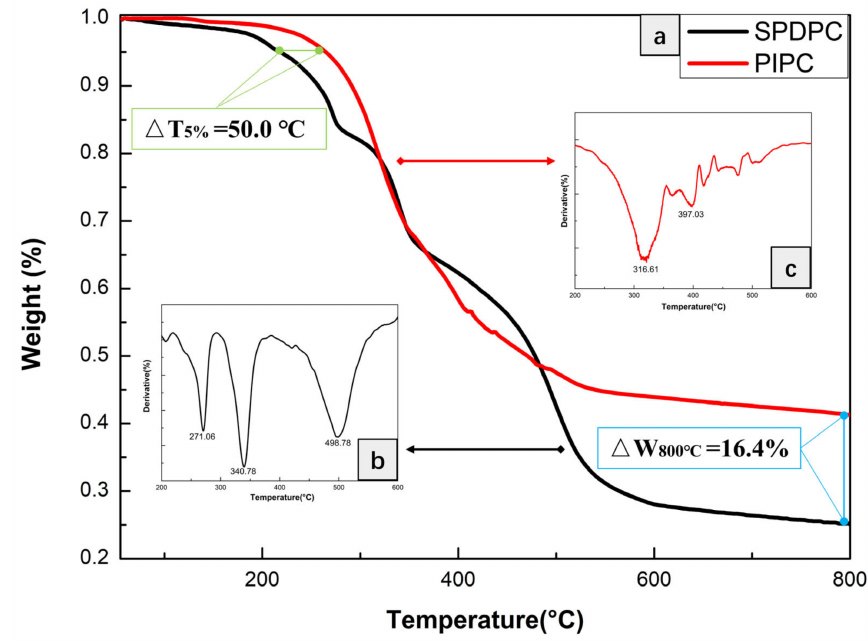
Figure 3. Thermogravimetry (TGA) curves of SPDPC and PIPC ( a ); Di ff erential thermogravimetry (DTG) curves of SPDPC ( b ) and PIPC ( c